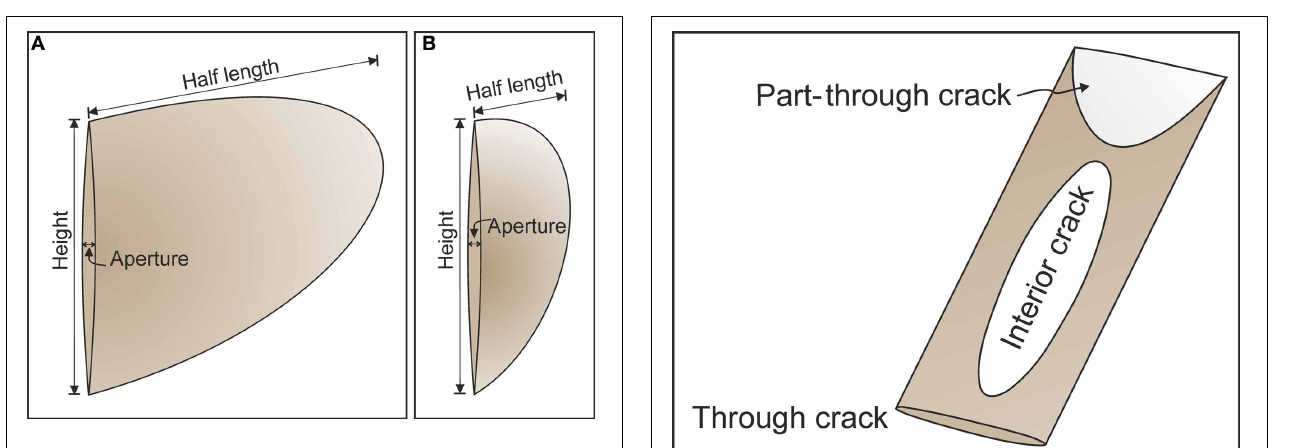
FIGURE 2 | The length of a fracture is its horizontal (strike) dimension, its height is the vertical (dip) dimension, and its aperture is the maximum thickness measured perpendicular to the fracture walls. (A) If the height is smaller than the length, the fracture aperture is correlated to the fracture height. (B) If the height is larger than the length, the fracture aperture correlates with the fracture length. The smaller of the strike and dip dimension is therefore referred to as the controlling dimension of the fracture (modified from Gudmundsson, 2000b).